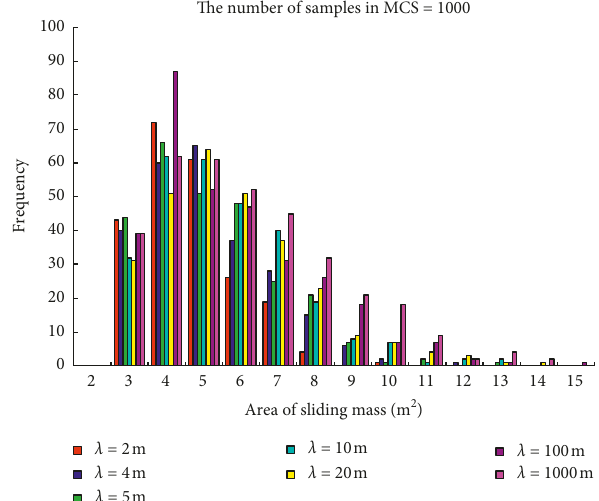
Figure 8: Histogram of area of sliding mass by proposed